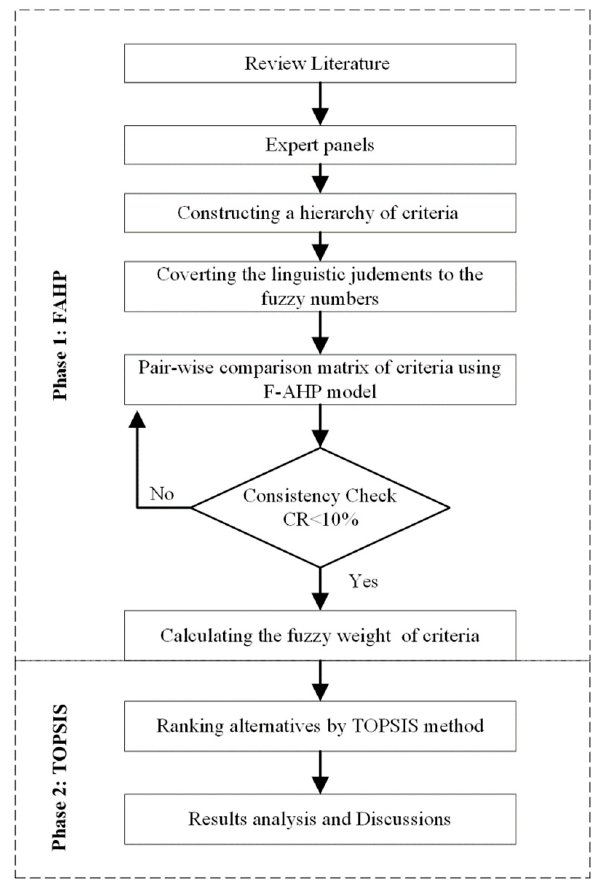
Figure 1. The research framework.